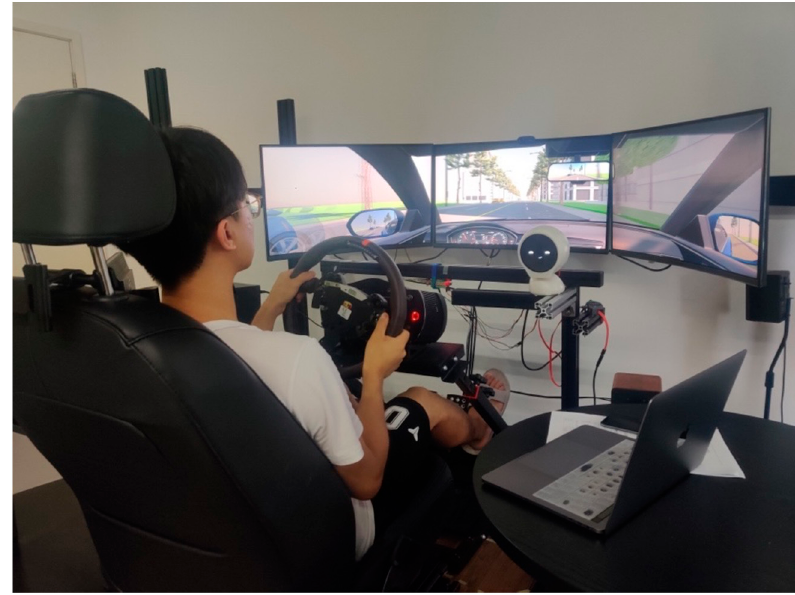
Figure 6. Driving simulation.